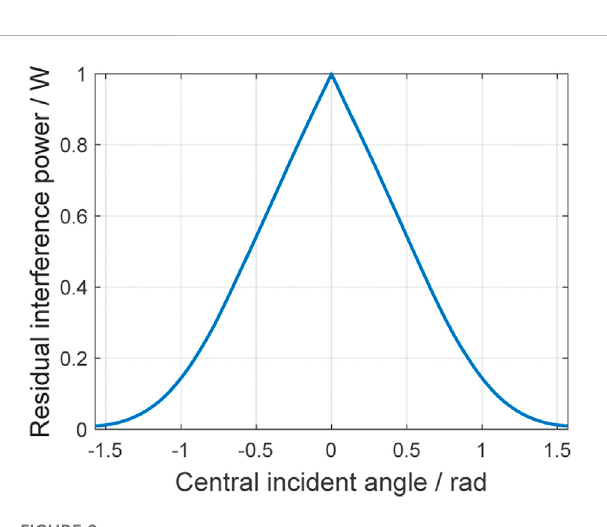
FIGURE 9 Relationship between the optimal residual interference power and the interference central incident